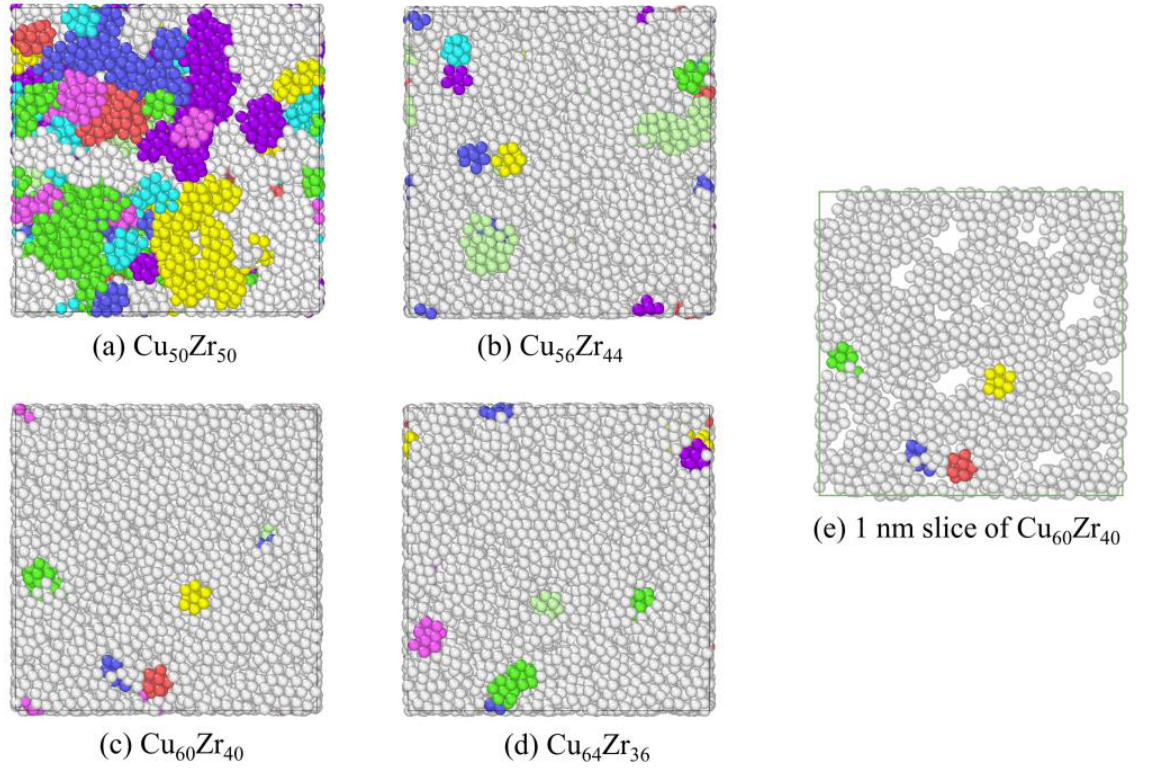
Figure 7. ( a – d ) are the cube bone of Cu X Zr 100 − X (x = 50, 56, 60, 64) MGs, respectively. The clusters connected together were colored using the same color. ( e ) 1 nm slice of Cu 60 Zr 40 .